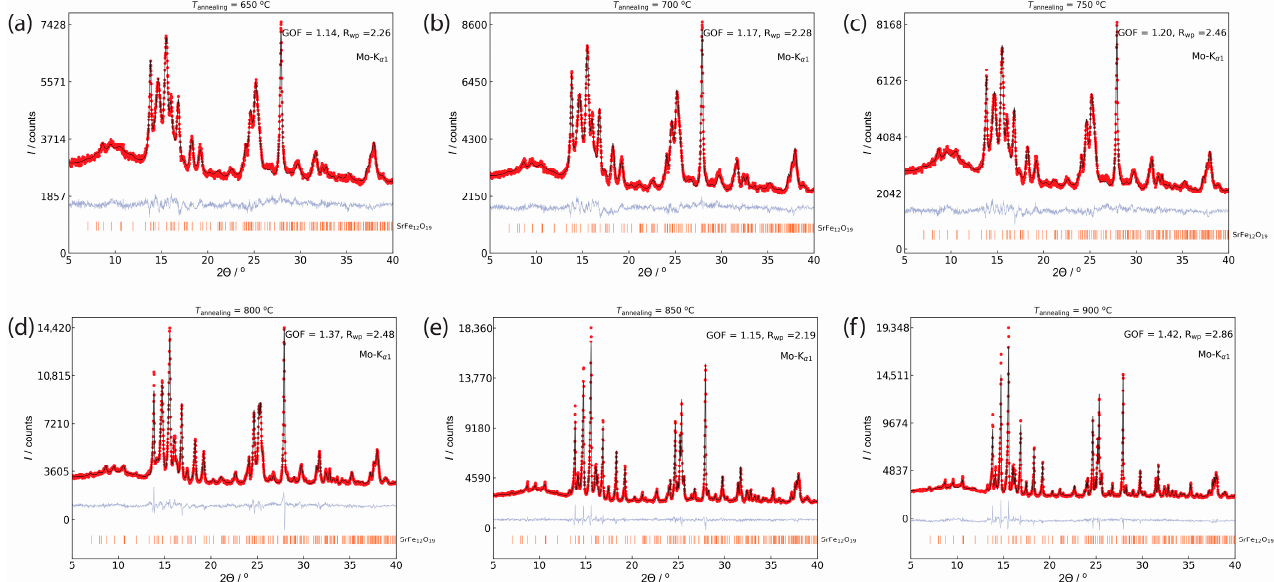
Figure 2. XRD patterns and Rietveld analyses of the extracted hexaferrite powders obtained at different annealing temperatures: ( a ) 650 ◦ C; ( b ) 700 ◦ C; ( c ) 750 ◦ C; ( d ) 800 ◦ C; ( e ) 850 ◦ C; ( f ) 900 ◦ C. Black lines, red lines, and light blue lines are the observed and calculated patterns, and their differences, respectively. The orange bars correspond to the peak position of the hexaferrite phase (ICDD PDF 84-1531). Table 1. Properties of the hexaferrite particles extracted from glass-ceramics.